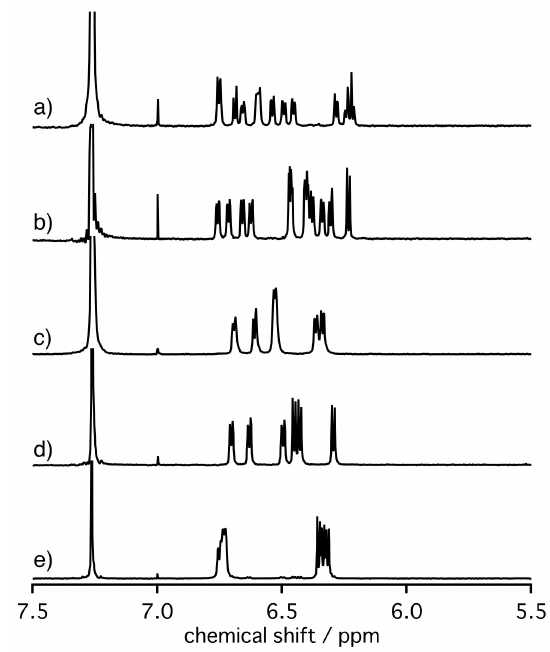
Figure 4. ( d ) 3BF 2 -Me-Hex(a), and ( e ) 3BF 2 -Me-Hex(b) in CDCl 3